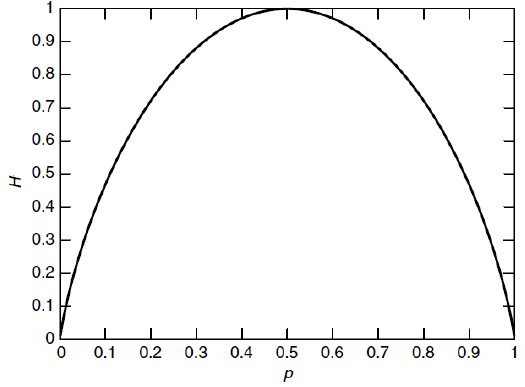
Figure 3. Entropy vs.